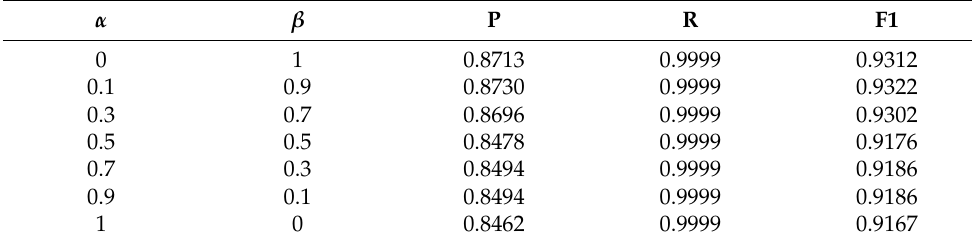
Table 5. Performance comparison of different α and β on P1